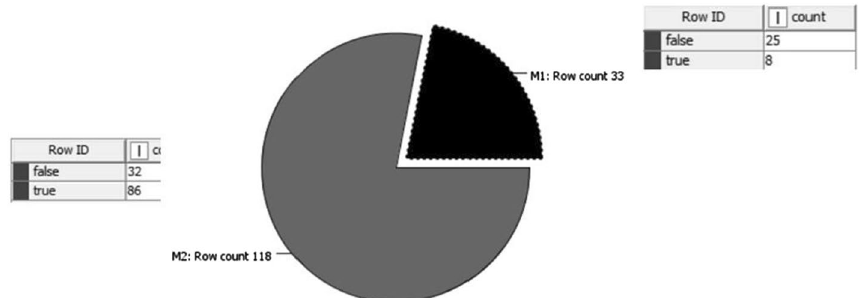
Fig. 4 Pie chart on the machine operation occurrences